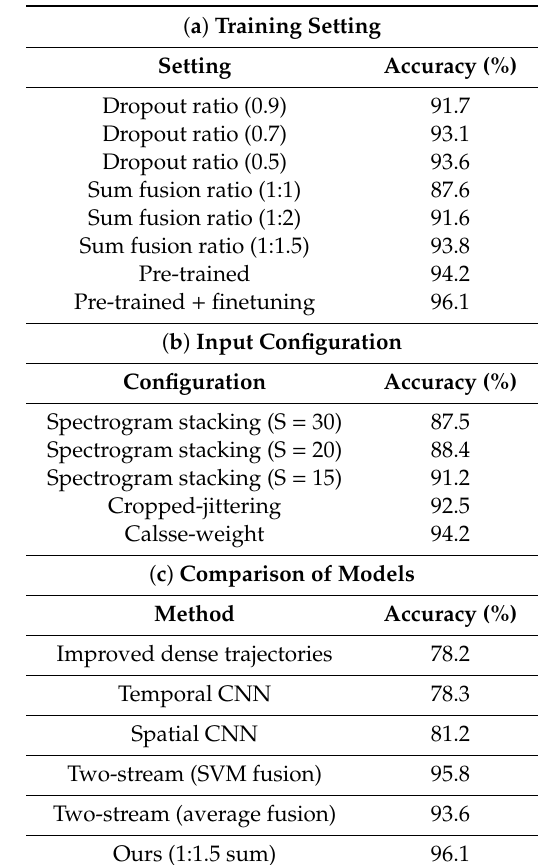
Table 4. ( a ) Di ff erent accuracy of model based on di ff erent dropout ratio, fusion ratio, and method of pre-training; ( b ) di ff erent configuration of input data; ( c ) correct detection of each